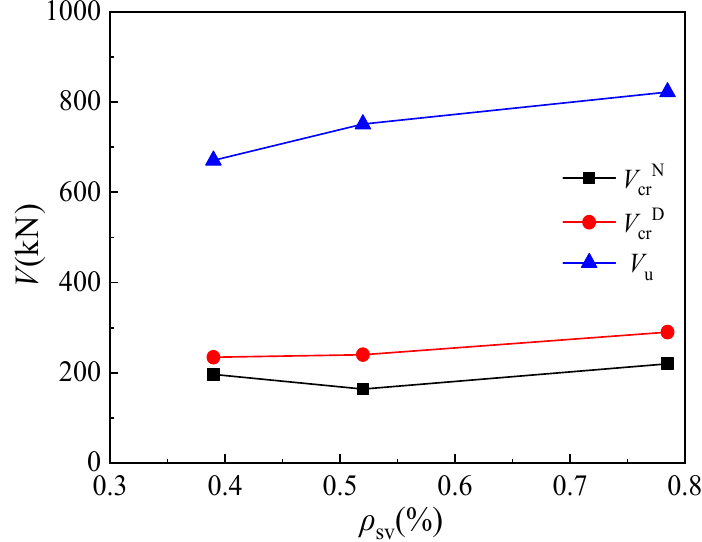
Figure 12. Relationship between load and stirrup reinforcement ratio.